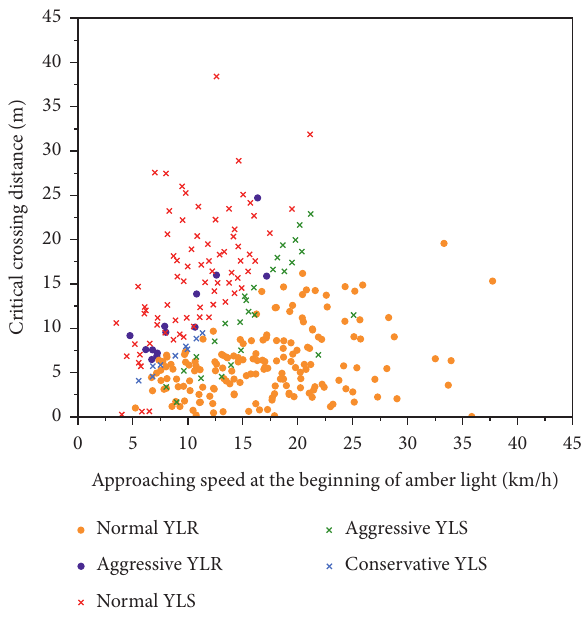
Figure 8: Stop-go decision types in the AS-CCD